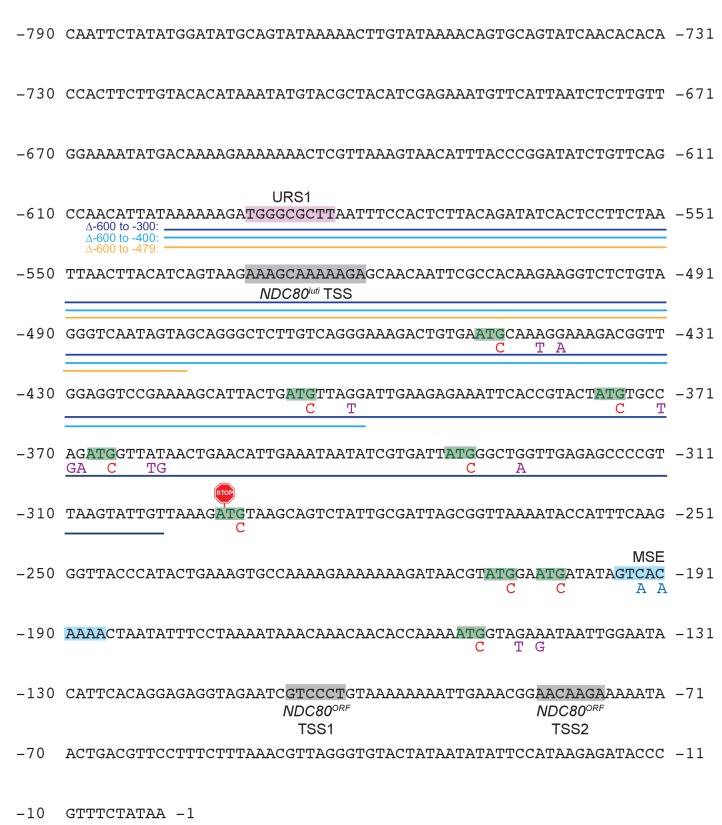
Annotated upstream intergenic region of the NDC80 locus and engineered mutations used in this study.The numbers on both sides of the nucleotide sequence indicate the distance away from the NDC80 ORF start codon. Regions of the transcription start sites (TSS) for NDC80luti and NDC80ORF, as estimated from a published RNA-seq dataset (Brar et al., 2012), are highlighted in grey. NDC80ORF has two detectable regions of the transcription start sites (TSS1 and TSS2). The different ∆NDC80luti constructs used in this study are marked: dark blue for the −600 to −300 deletion (Figure 4A and D), light blue for the −600 to −400 deletion (Figure 7A), and orange for the −600 to −479 deletion (Figure 4B and C). Below each ATG of the 9 AUG uORFs (highlighted in green), the red letter ‘C’ represents the G to C mutations engineered to abolish uORF translation in the Δ6AUG and Δ9AUG strains (Figure 3). The purple letters represent the nucleotides mutated in the mini uORF strain to generate a stop codon (UGA) at the third codon position for every AUG uORF. The site at which the terminator sequence was inserted is indicated by a stop sign.